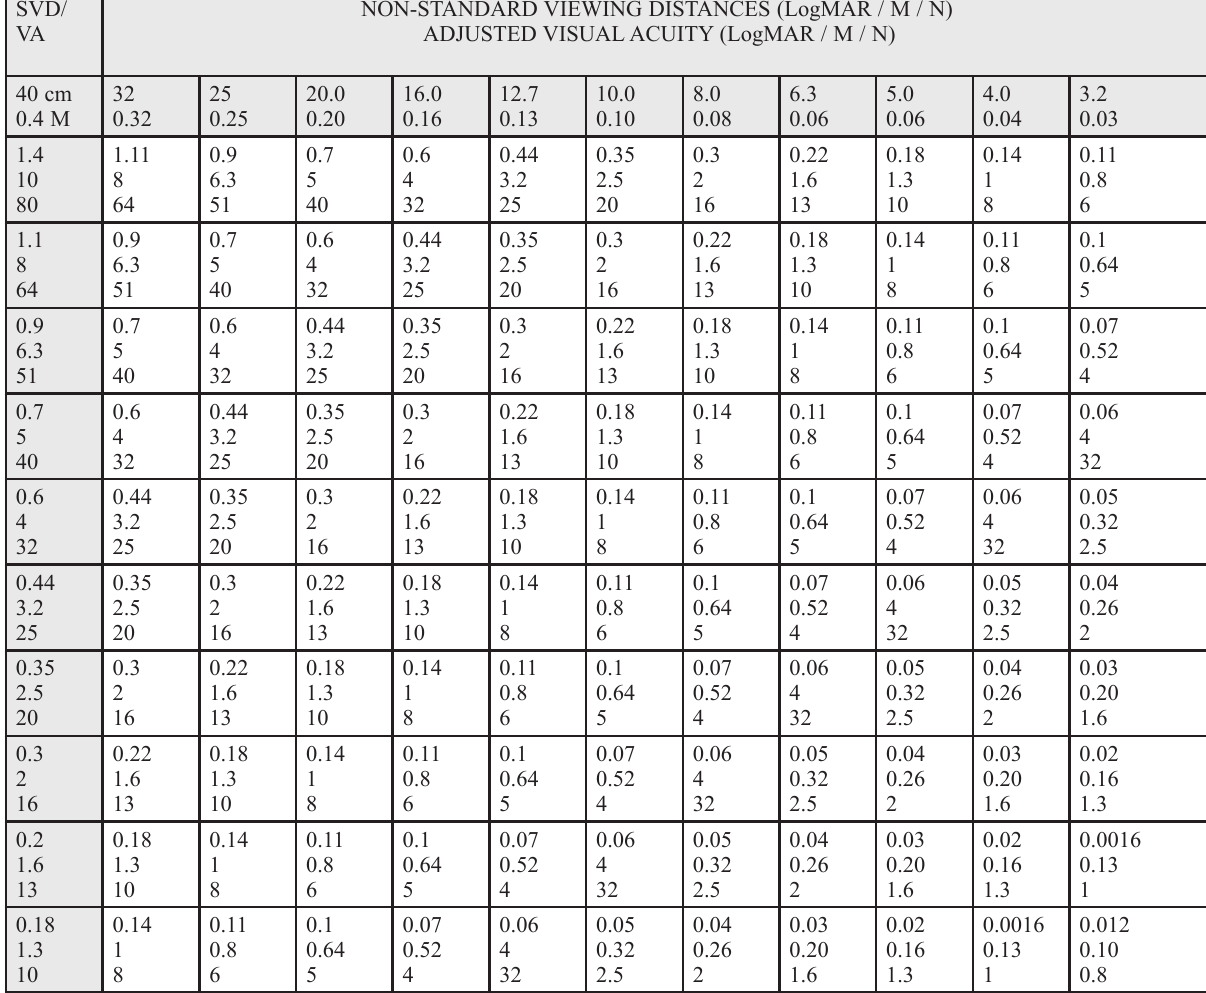
Table 1. The applications and advantages of the